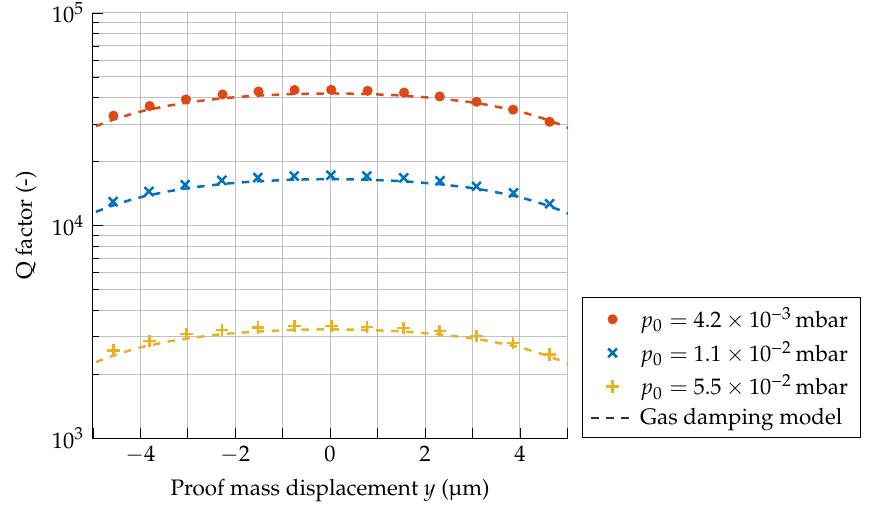
Figure 6. Q factors in air as a function of proof mass displacement for a MEMS accelerometer with f 0 =